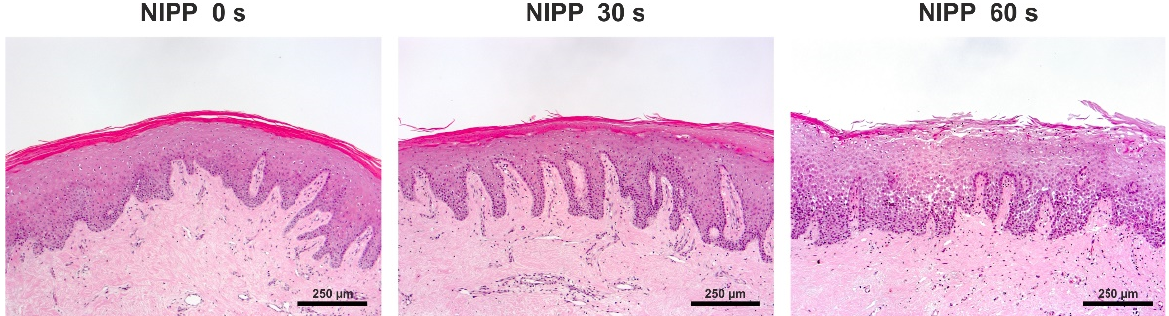
Figure 7. Effects of NIPP on gingival tissue biopsies at 24 h after NIPP treatment for 30 s and 60 s, as compared to the untreated group (NIPP 0 s). Hematoxylin and eosin (HE) staining, original magnification 10×. The scale bar represents 250 µm.